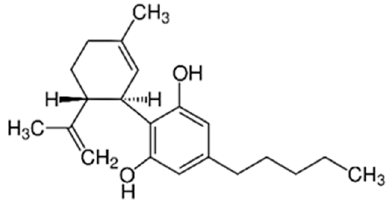
Figure 7. CBD structure.